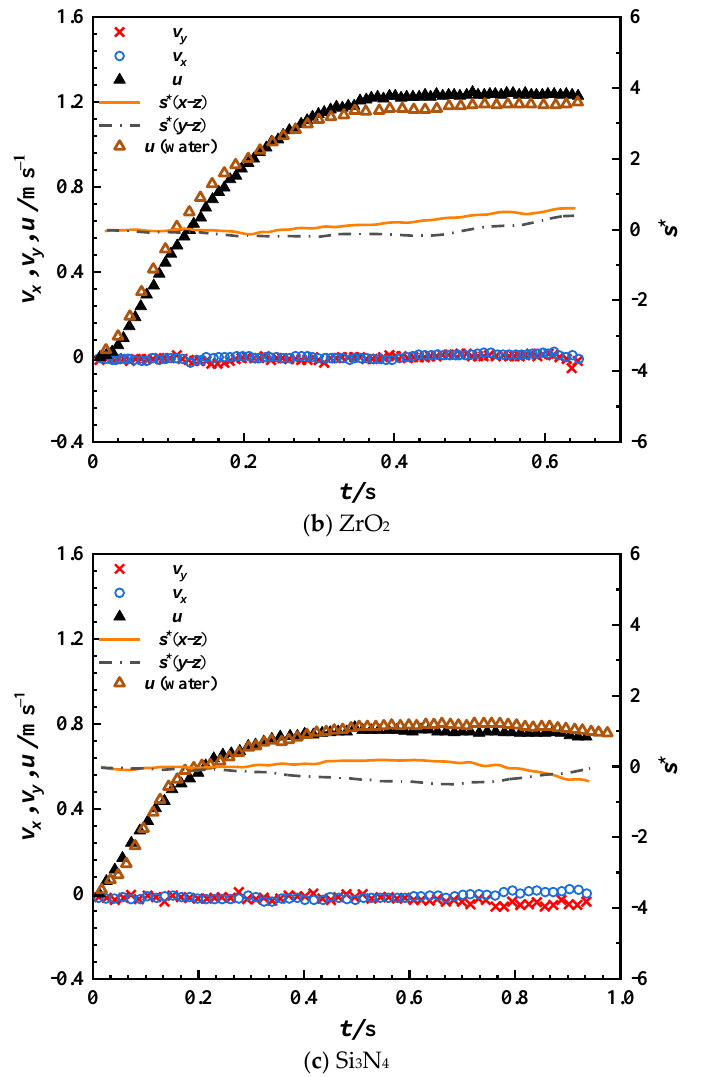
Figure 10. Variations in the trajectories and velocity of a single particle settling in PAAm solution. v x is the transverse velocity in x - z plane, v y is the transverse velocity in y - z plane, u is the vertical velocity.